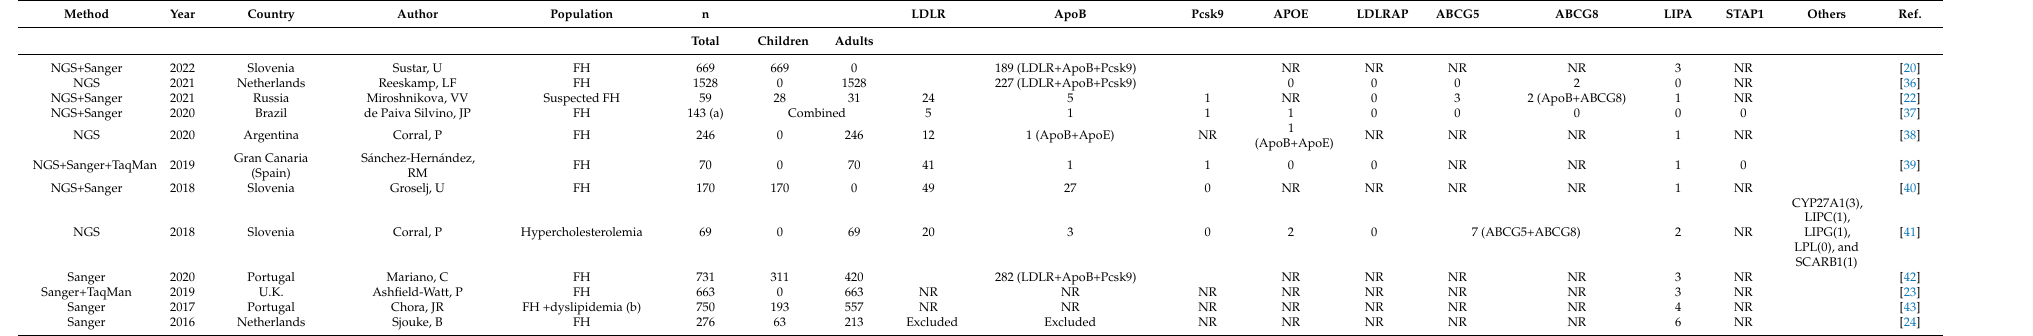
Table 2. High-risk screening for LAL-D using genetic